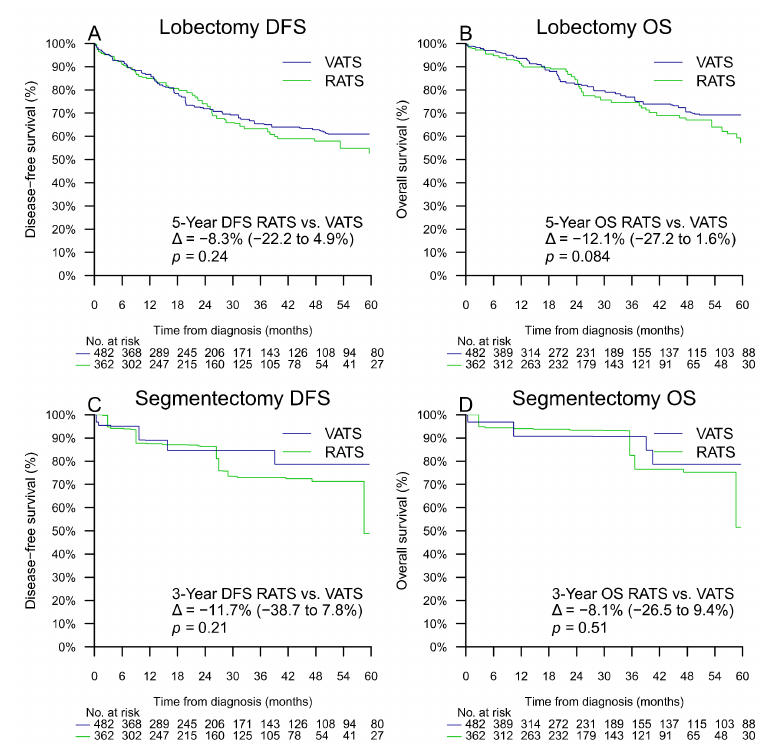
Figure 3. Propensity-score adjusted DFS for lobectomy ( A ), OS for lobectomy ( B ), DFS for segmentec- tomy ( C ), and OS for segmentectomy ( D ). ∆ represents the difference of percentage of survival with its 95% confidence